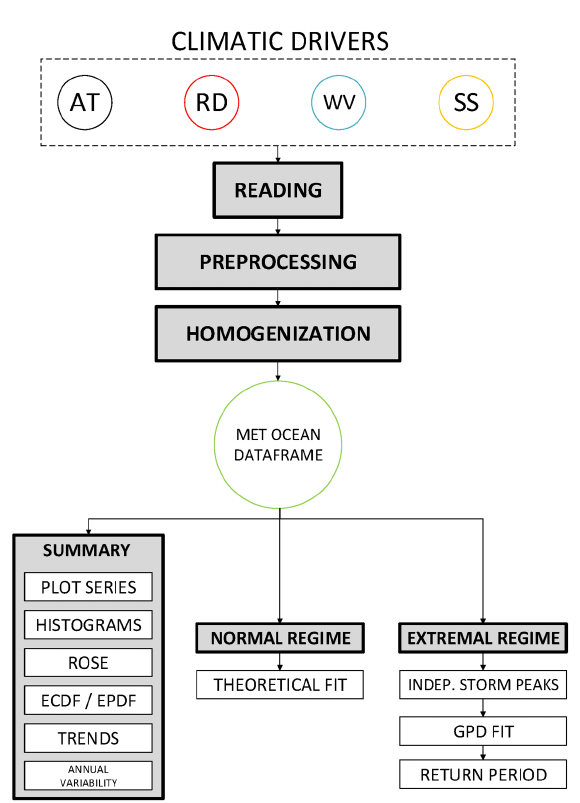
Figure 1. Scheme of the different modules of the tool. AT, RD, WV and SS stand for Astronomical Tide, River Discharge, Wave and Storm Surge,